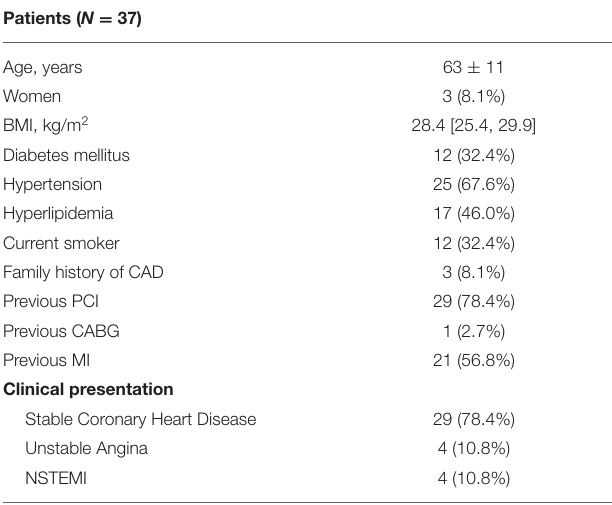
TABLE 3 | Plaque morphologies.